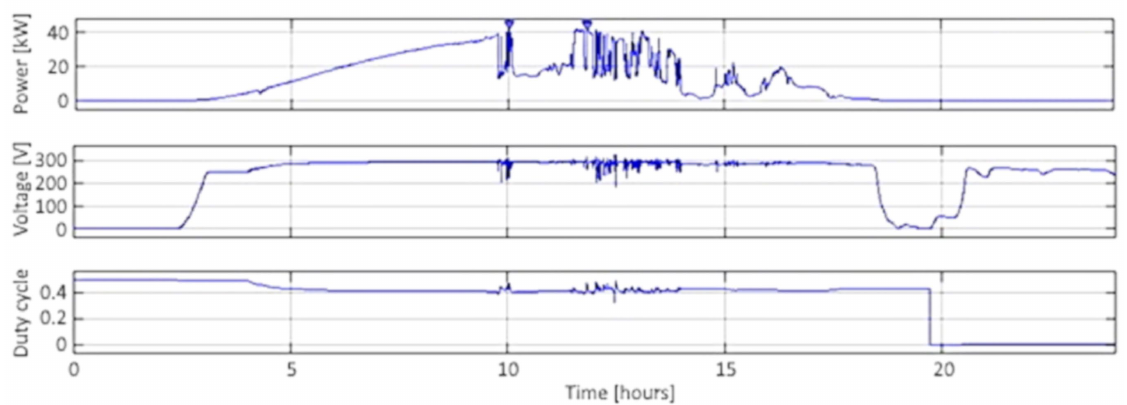
Figure 29. Graph of the power of photovoltaic modules and the average voltage across them and the duty cycle for a 39.65 kW installation on a sample day in July. duty cycle for a 39.65 kW installation on a sample day in